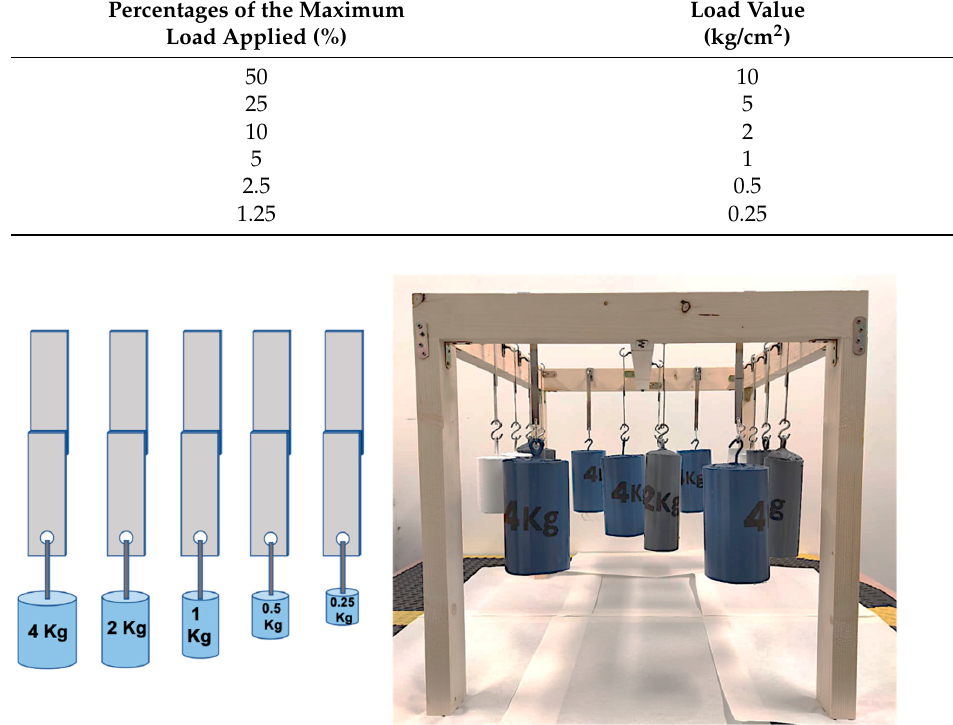
Figure 3. Creep tests illustration and setup.